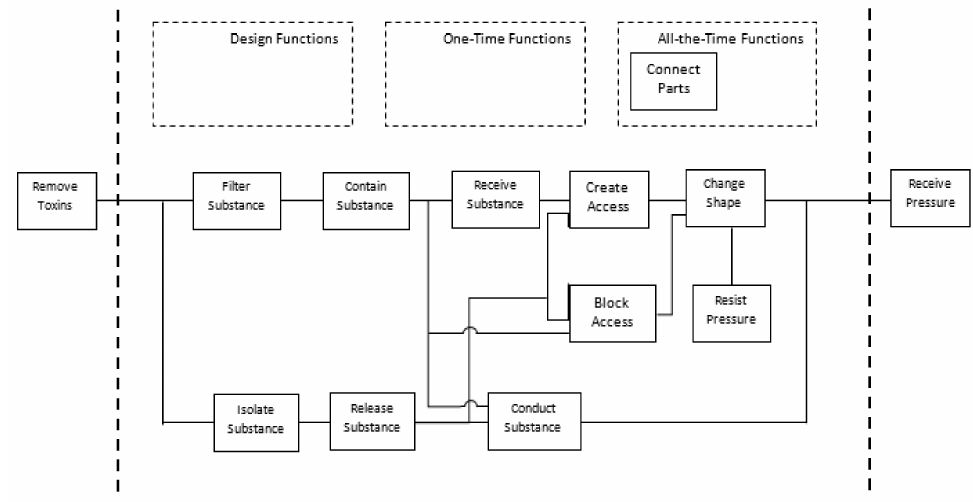
Figure 2. FAST diagram of the device to be designed